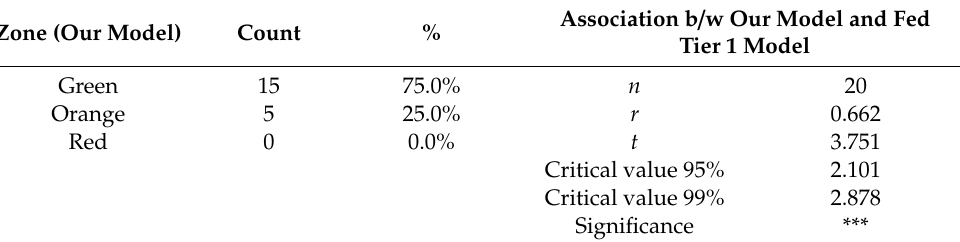
Table 3. Summary statistics for 20 US banks.